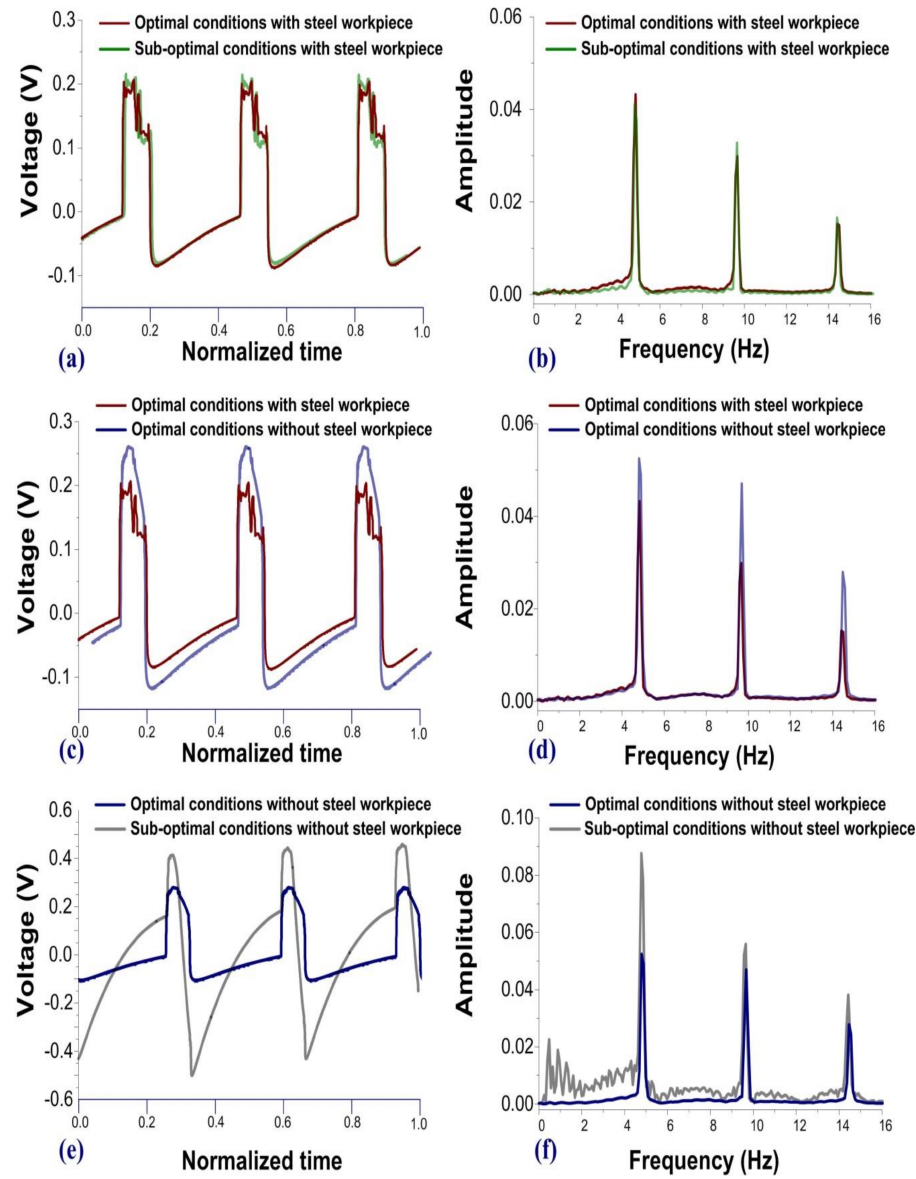
Figure 9. Results of comparison between ( a , c , e ) time domain waveforms and ( b , d , f ) FFT spectra: (1) a mechanical mold with blunt edges required greater cutting force than did a mold with sharp edges; (2) loading a steel workpiece induced a high-frequency component, regardless of edge condition; and (3) operating the machine without a steel workpiece provided a high SNR ratio, regardless of edge